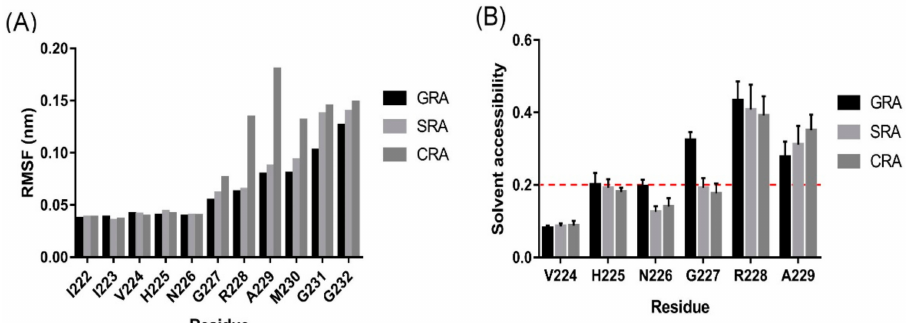
Figure 5. Comparative analysis of the dynamics of CBD-INT-OCV-cecB2 fusion protein variants: ( A ) the root-mean-square fluctuations (RMSF) of C α atoms in the cleavage sequence calculated from the molecular dynamics (MD) simulations; ( B ) the solvent accessibility of residues in the cleavage sequence. The solvent accessibility was calculated from MD simulation snapshots. A cuto ff of 20% (red dashed line) was used to define the two states—buried or